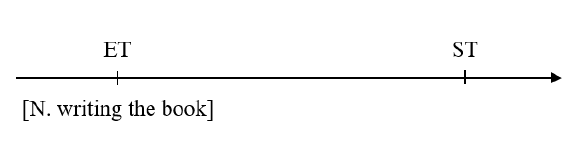
Figure 4. Past temporal frame